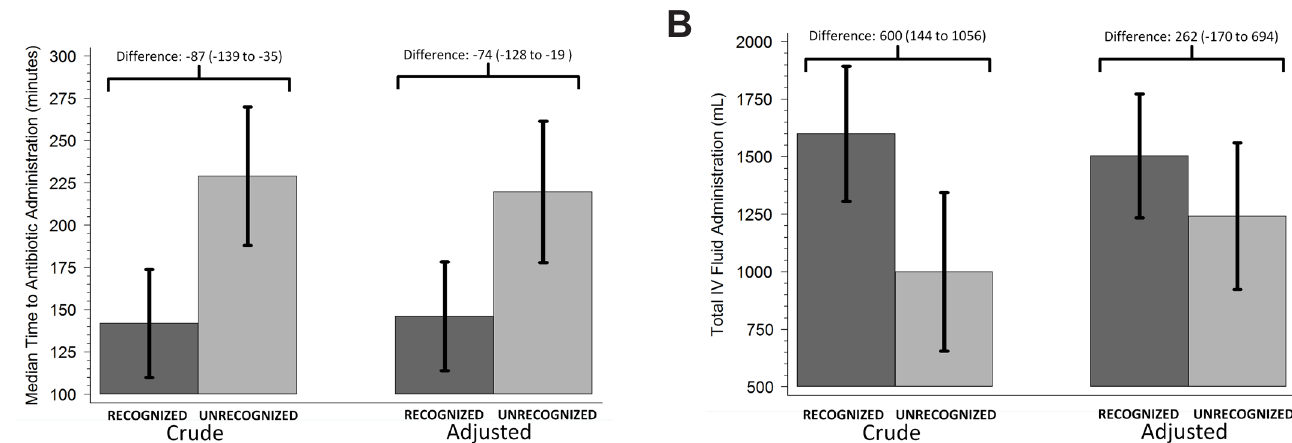
Figure 2. A , Comparison of crude and adjusted medians and differences between RECOGNIZED (dark gray) and UNRECOGNIZED (light gray) groups for time to antibiotic administration and B , total intravenous (IV) fluid administration in the emergency department. Bars indicate 95% CIs for medians. Median differences (95% CIs) are reported above each comparison. We calculated medians and median differences, along with 95% CIs, using median regression. Adjusted values were calculated using multivariable analyses adjust - ing for patient age, sex, and sepsis severity (septic, severe sepsis, or septic